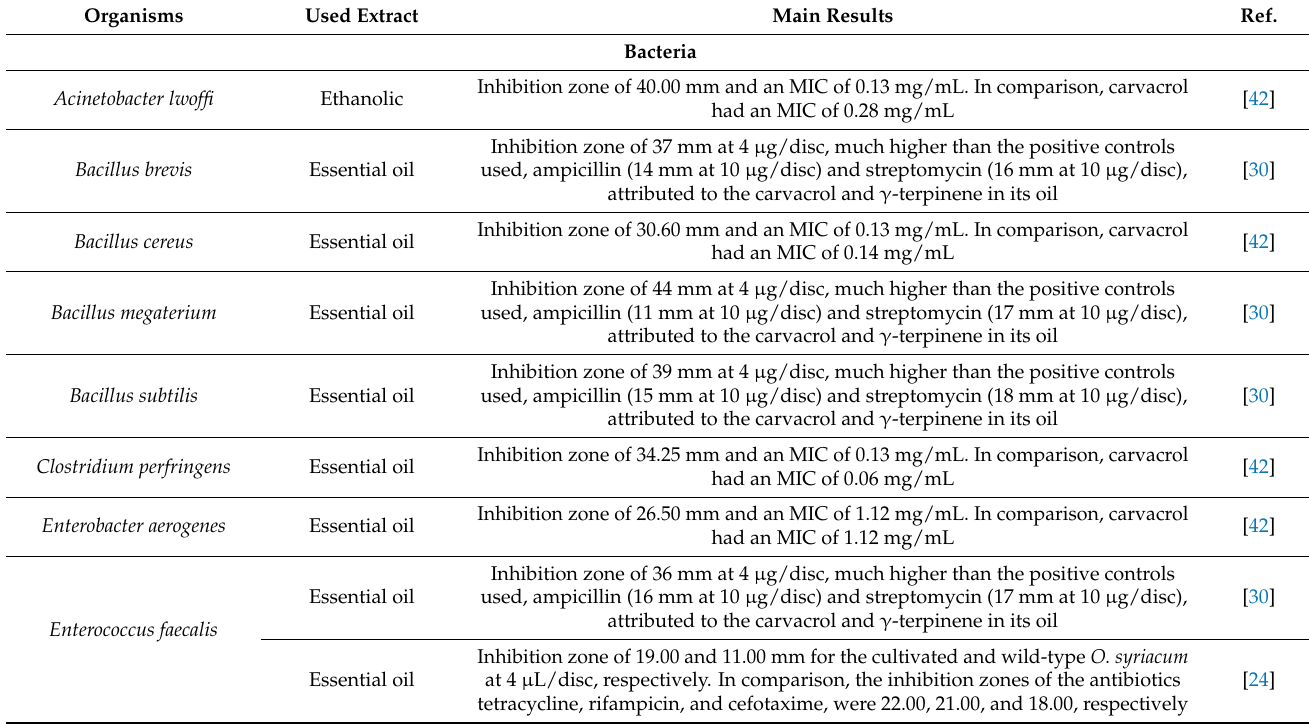
Table 4. Antimicrobial and pesticidal activities of Origanum syriacum . MIC: Minimum inhibitory